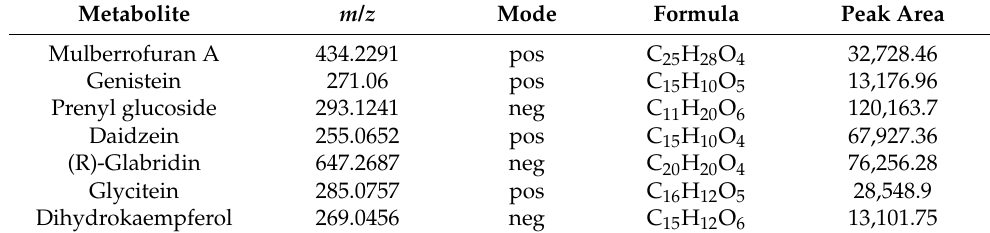
Table 3. Flavonoids in J-15-Ms.